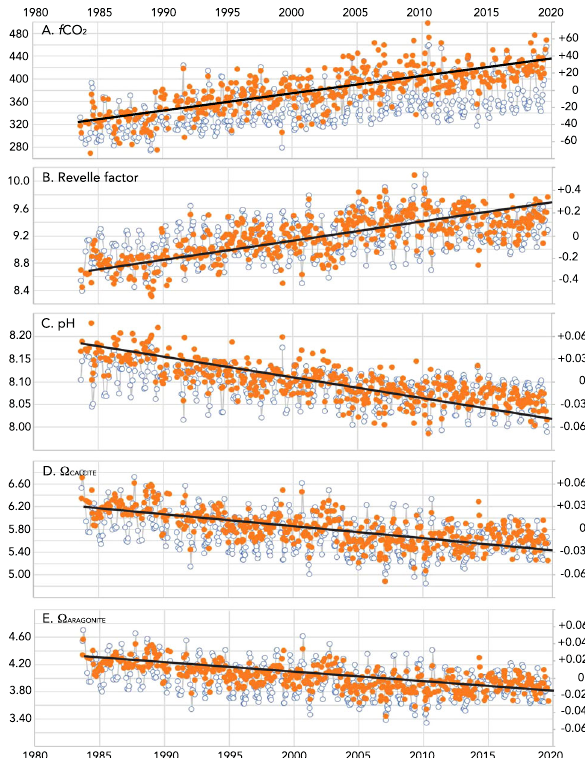
Fig. 2 Hydrographic and seawater CO 2 – carbonate properties at the BATS site (1988 – present) with earlier data (1983 – 1988) from Hydrostation S. Observed data (left vertical axis; open blue symbols) and anomalies (right vertical axis; orange symbols) are shown. Regression lines are from anomaly data plotted in the right vertical axis and given in Table 1. a Surface f CO 2 and anomalies ( µ atm). b Surface revelle factor ( β ) and anomalies. c Surface pH and anomalies. d Surface Ω calcite and anomalies. e Surface Ω aragonite and